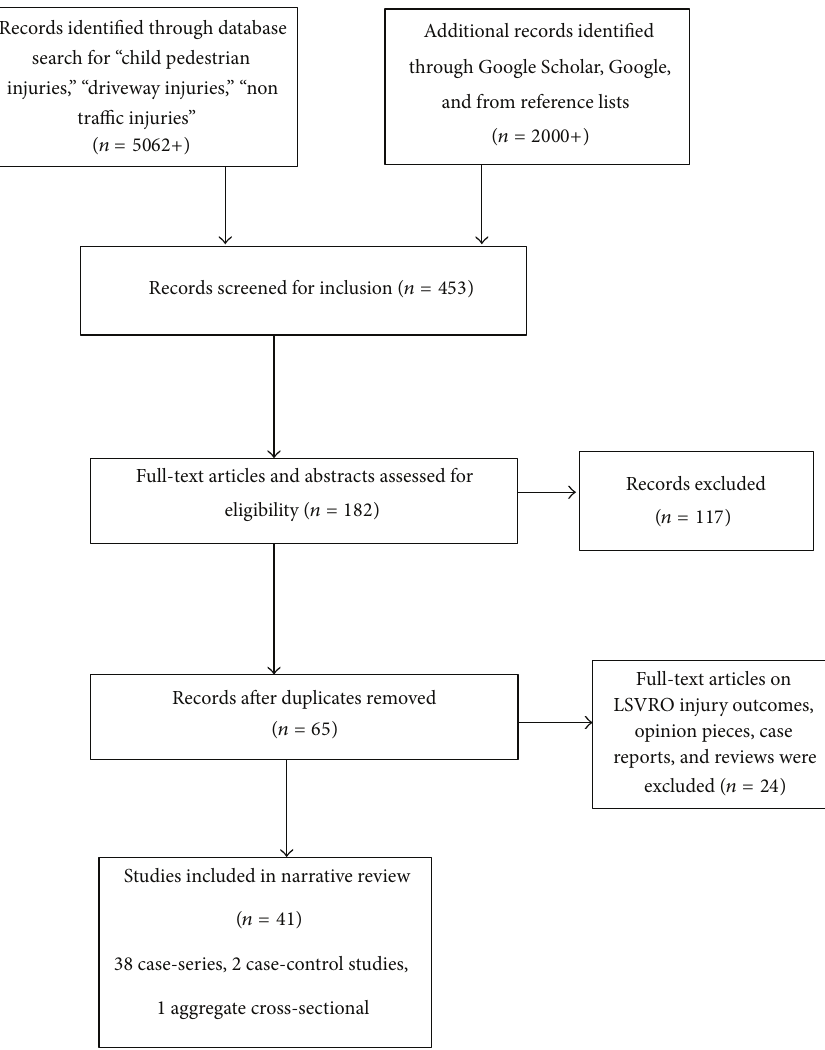
Figure 1: Steps for inclusion of articles in the systematic narrative